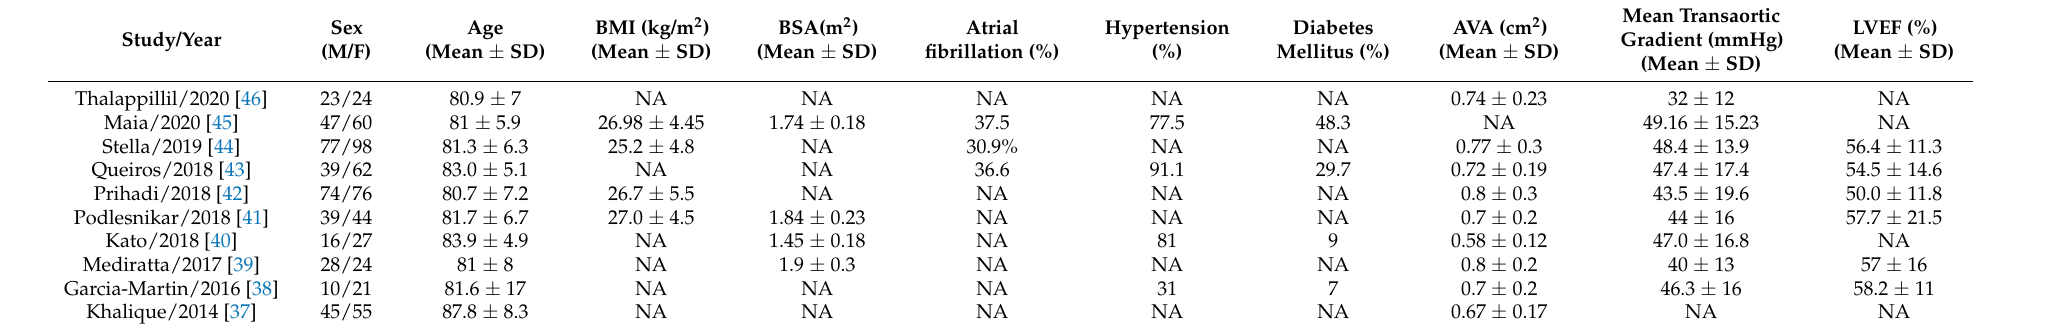
Table 2. Patient characteristics of included studies.